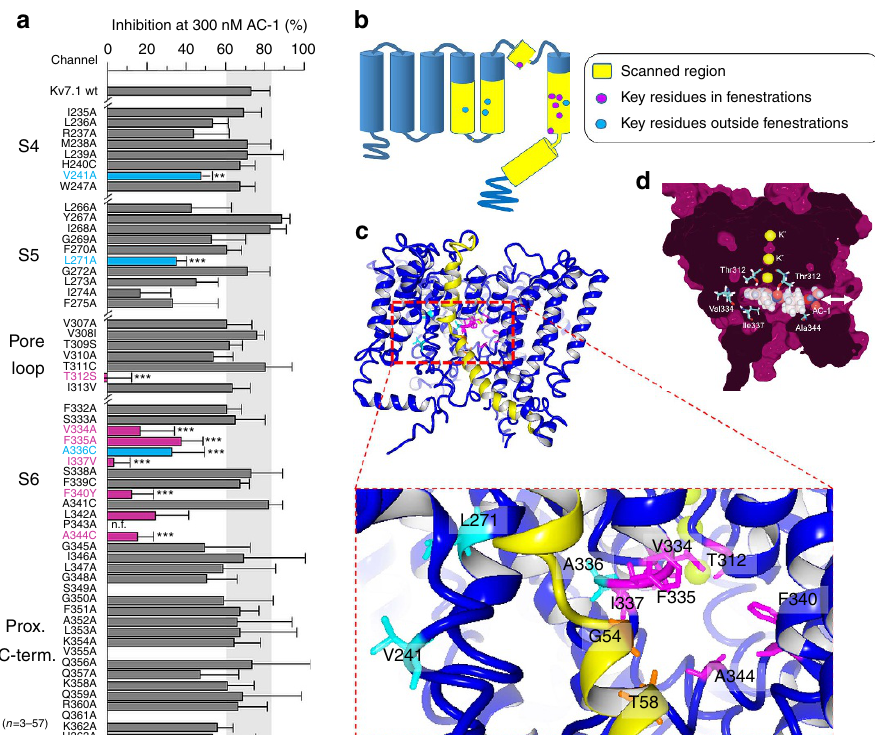
Figure 3 | Putative binding mode of AC-1. ( a ) Inhibition of wt and mutant Kv7.1/KCNE1 channels by 300nM AC-1. Influence of amino acid exchange (yellow) on channel sensitivity to 300nM AC-1 was investigated using alanine scanning combined with TEVC. Inhibition was determined as percent change in current amplitude at the end of a depolarizing test pulse ( n ¼ 4–57, ± s.e.m.; one way analysis of variance, Dunnett’s post hoc test; *** P o 0.001). ( b ) Cartoon of a single Kv7.1 channel subunit with scanned region in yellow. The circles indicate positions of mutations that significantly alter AC-1 sensitivity (key residues). Magenta filled circles indicate residues that face into the fenestration and blue filled circles mark residues that do not face fenestrations. ( c ) A preopen closed state model of Kv7.1/KCNE1 (Kv7.1 colored blue, KCNE1 colored yellow) with key residues highlighted in magenta (fenestration facing), blue non-fenestration facing and orange (fenestration facing in KCNE1). ( d ) Molecular docking of AC-1 to a homology model of Kv7.1/KCNE1 (ref. 33). AC-1 was positioned in close proximity to the amino acid residues identified by alanine scanning. AC-1 is located in a fenestration, which is only formed in the presence of KCNE1 (ref. 35).